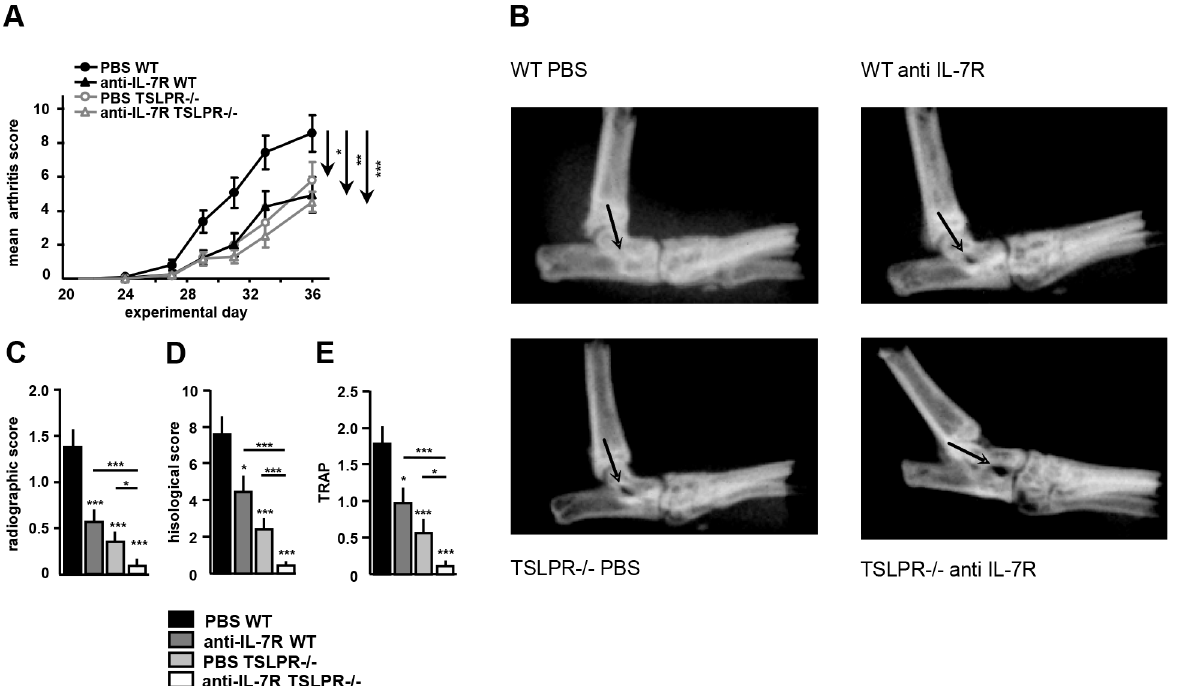
Fig 1. Arthritis severity is inhibited in TSLPR deficient mice and upon blockade of the IL-7R. WT or TSLPR-/- mice were treated with PBS or anti IL-7R α antibodies (anti IL-7R, 100 μ g ip. on day 21, 24, 27, 30, and 33) and arthritis severity was graded by visual examination of the paws. IL-7R blockade, TSLPR deficiency or a combination of both significantly decreased arthritis severity compared to PBS WT mice (A). The same was true for radiological joint damage (B, C), histology (D) and osteoclast formation as measured by the number of TRAP+ cells (E). Anti-IL-7R TSLPR-/- mice showed almost complete inhibition of joint damage. Values are mean ± SEM of 16 mice per group. * , ** , and *** indicate statistical differences of p < 0.05, p < 0.01, or p < 0.005